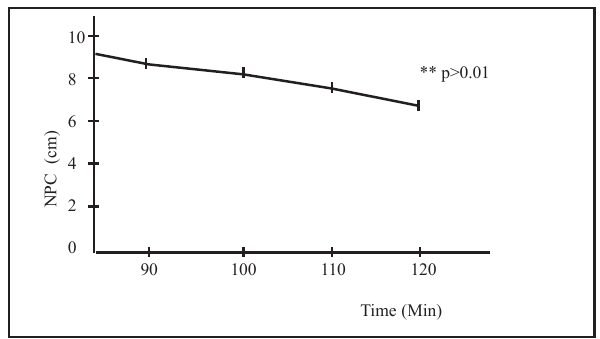
Figure 1: Effect of acute ingestion of Cola nitida (30g) on NPC of ten healthy volunteers. Each point represents the mean + SEM of 5 readings ( p >0.01). This improvement in NPC lasted for 2 hr before returning to baseline values.